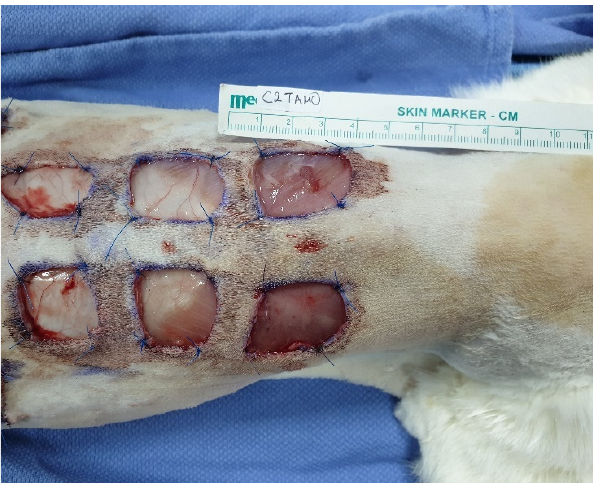
Figure 1. The six wounds created on each